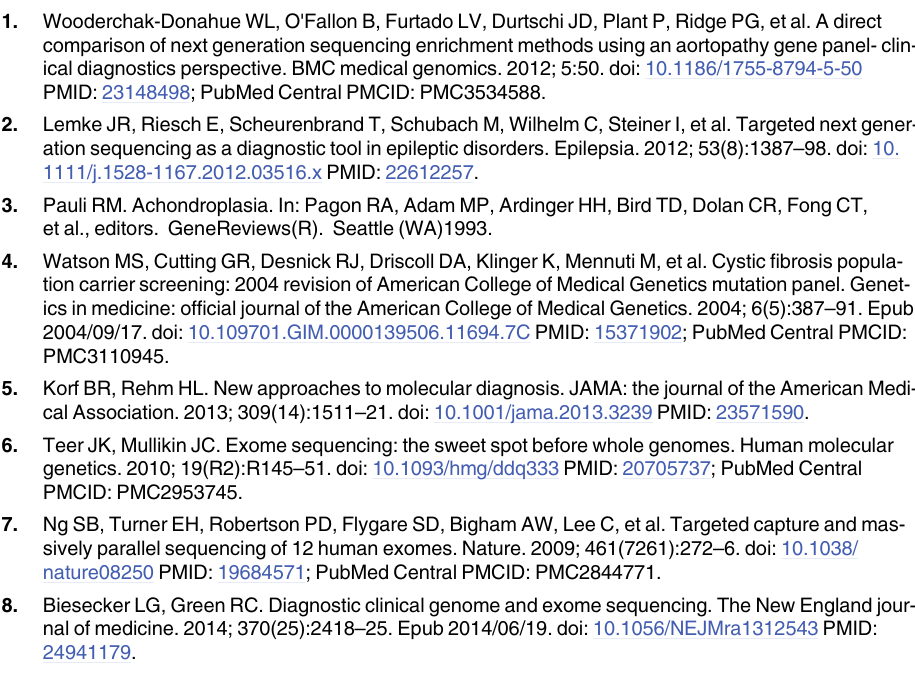
S1 Fig. Pattern of coverage distribution in sequenced targets. Most common distribution pattern: the target extremities have a lower coverage than the center. Samples varied principally in level of average coverage, which has the effect of shifting the curve vertically, with little varia- tion in curve shape. S1 Table. List of patients and their respective clinical data and medical diagnoses. (XLS) S2 Table. List of the 309 selected genes known to be involved in genetic disorders of the skeleton, used in the gene panel design, alongside the associated phenotypes.